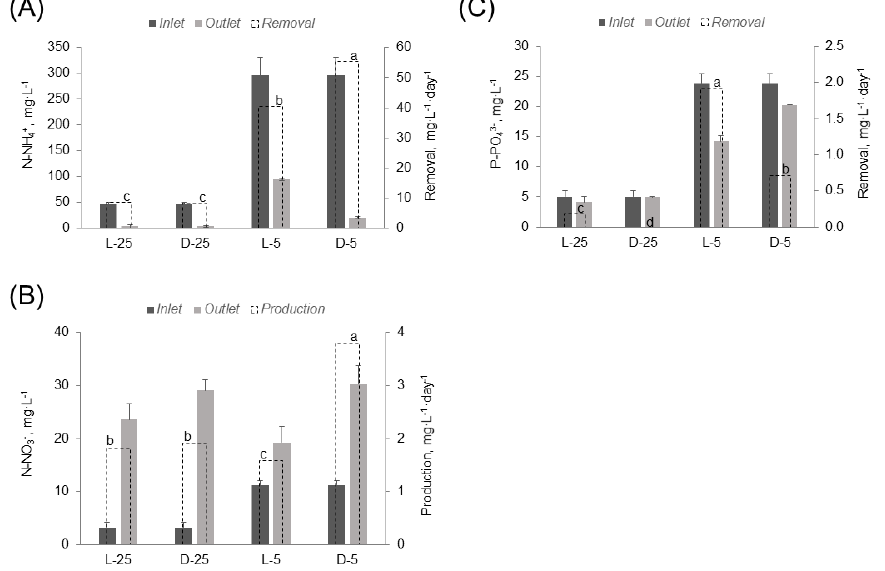
Figure 2. Inlet and outlet concentration and removal/production of ( A ) N-NH 4+ , ( B ) N-NO 3− , and ( C ) P-PO 43− in L-25, D-25, L-5, and D-5. Different letters indicate significant differences.